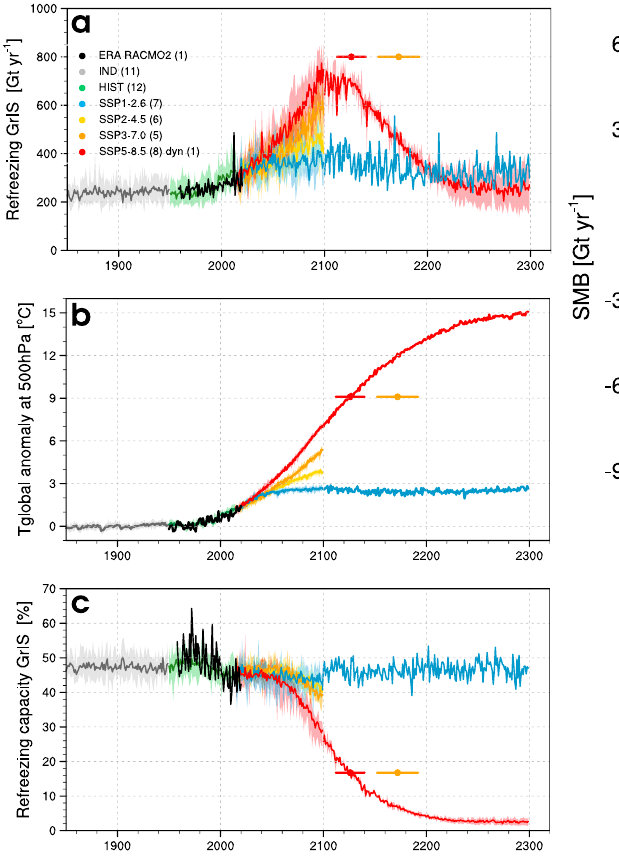
Fig. 5 | GrIS peak refreezing and contribution to sea level rise. a Time series of GrIS-integrated refreezing for the period 1850 – 2300. Thick coloured lines repre- sent ensemble mean refreezing at 1 km from 11 pre-industrial (IND), 12 historical (HIST) and 27 scenario projections, i.e., SSP1-2.6 (6 CESM2 and 1 RACMO2 mem- bers), SSP2-4.5 (6 members), SSP3-7.0 (5 members), and SSP5-8.5 (8 CESM2 and 1 RACMO2 members). One CESM2 SSP5-8.5 scenario includes ice dynamics